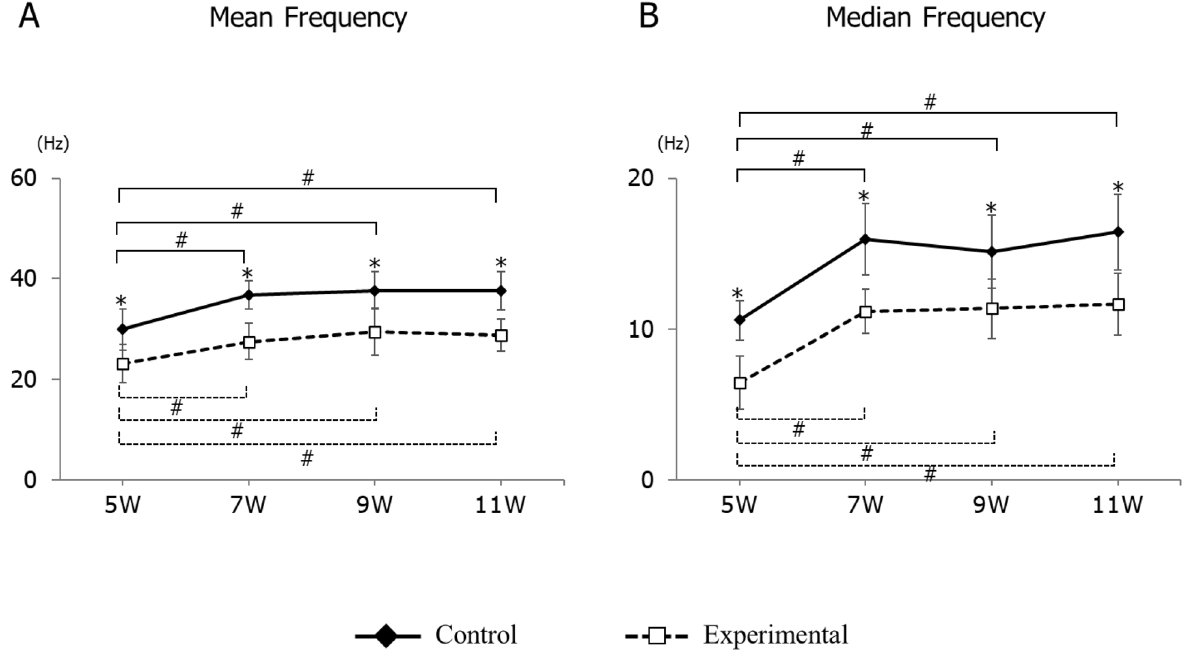
Figure 4. Longitudinal changes in mean frequency ( A ) and median frequency ( B ) of electromyographic activity in the control and experimental groups. Data are displayed as mean ± standard deviation. *p < 0.05 denotes significant differences between control and experimental groups. # p < 0.05 denotes significant differences between different ages within the same